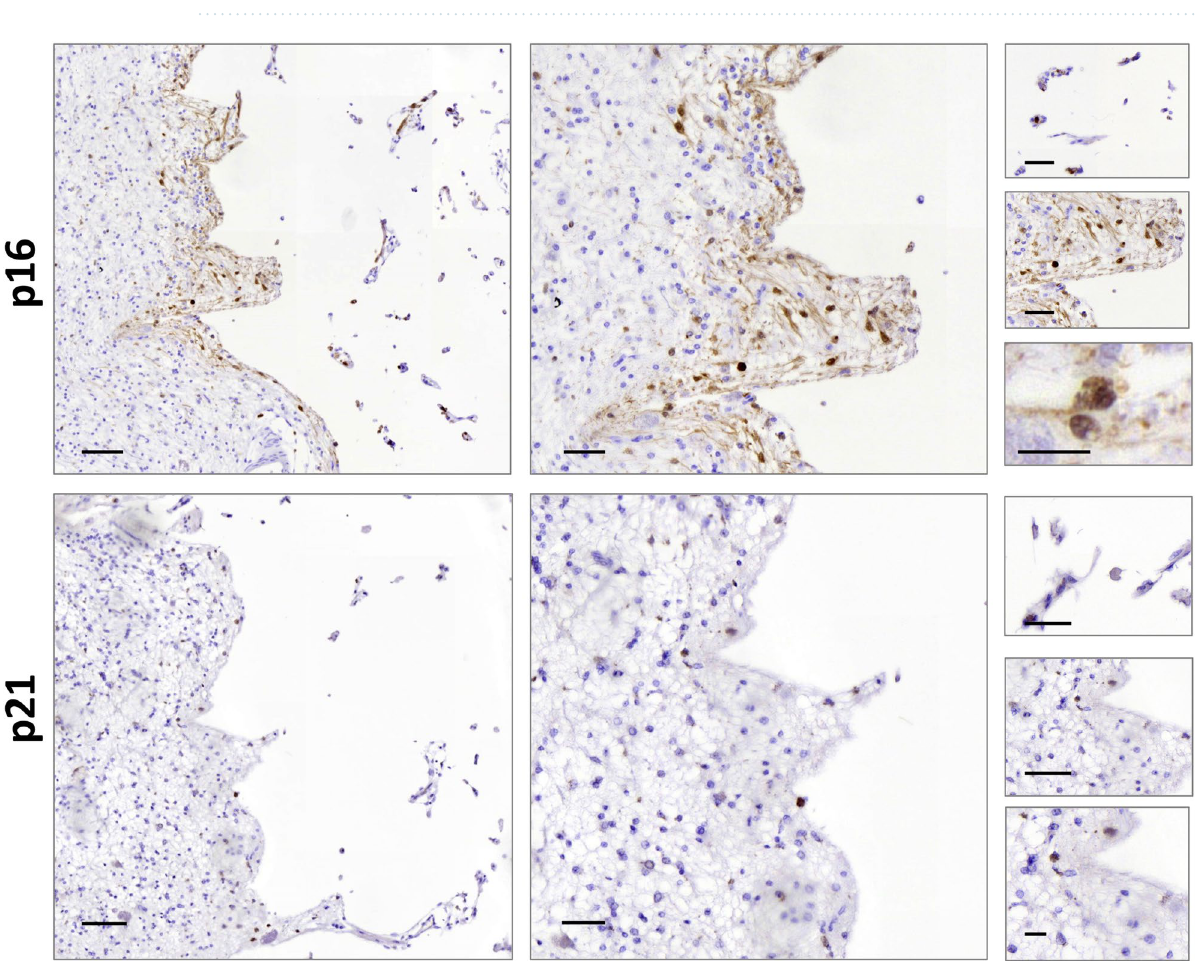
Figure 4. P16 and P21 subcellular location in MCA ischemic stroke patient’s brain tissue. Scale bar left images = 100 µm, middle images = 50 µm and right images = 20